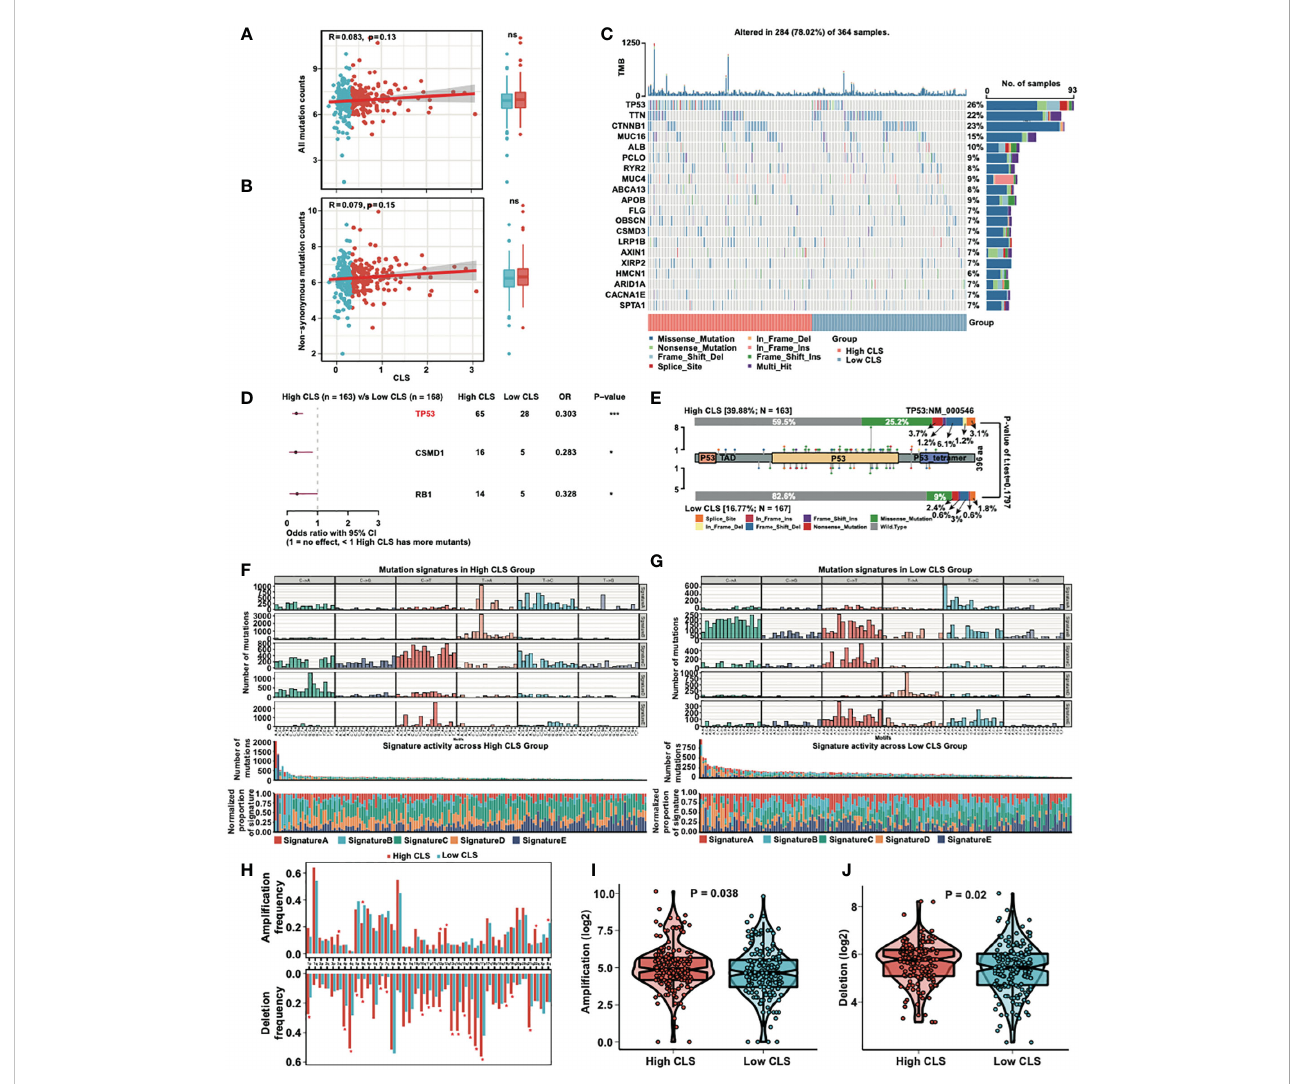
FIGURE 6 Mutational analyses of the CLS model. (A) The correlation between the all mutation counts and the CLS, and the number of all mutation counts in high and low CLS samples. (B) The correlation between the non-synonymous mutation counts and the CLS, and the number of all mutation counts in high and low CLS samples. (C) The waterfall plot of the top 20 altered mutation in high and low CLS samples. (D) The differentially mutated genes between high and low CLS samples. (E) The proportion and the types of the TP53 mutation in high and low CLS samples. (F) The number of mutations in fi ve mutational signatures in high CLS samples. (G) The number of mutations in fi ve mutational signatures in low CLS samples. (H) The ampli fi cation and deletion frequency in each arms between high and low CLS samples. (I) The total frequency of ampli fi cation in high and low CLS samples. (J) The total frequency of deletion in high and low CLS samples. TMB, Tumor mutational